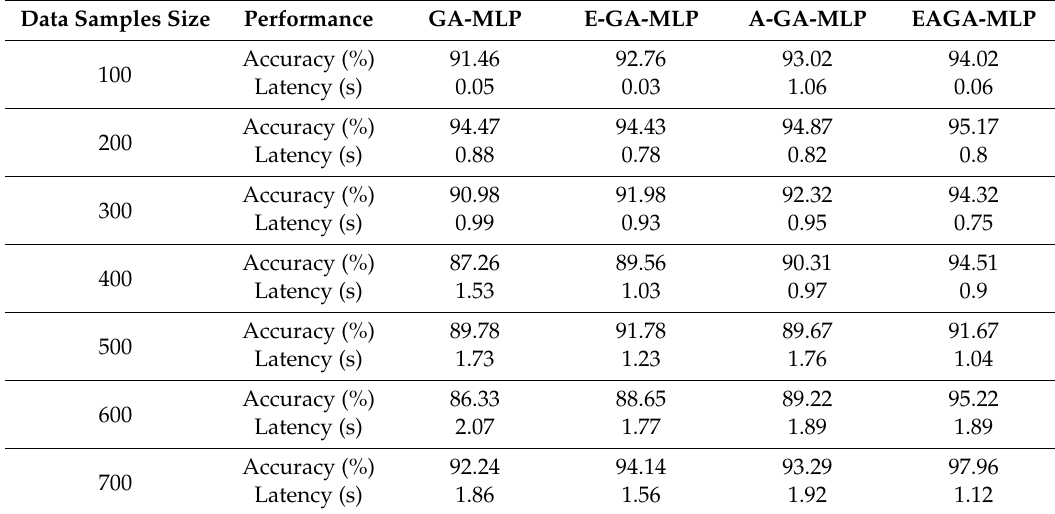
Table 21. Comparative analysis of classification accuracy of EAGA with GA, E-GA and A-GA. Data Samples Size